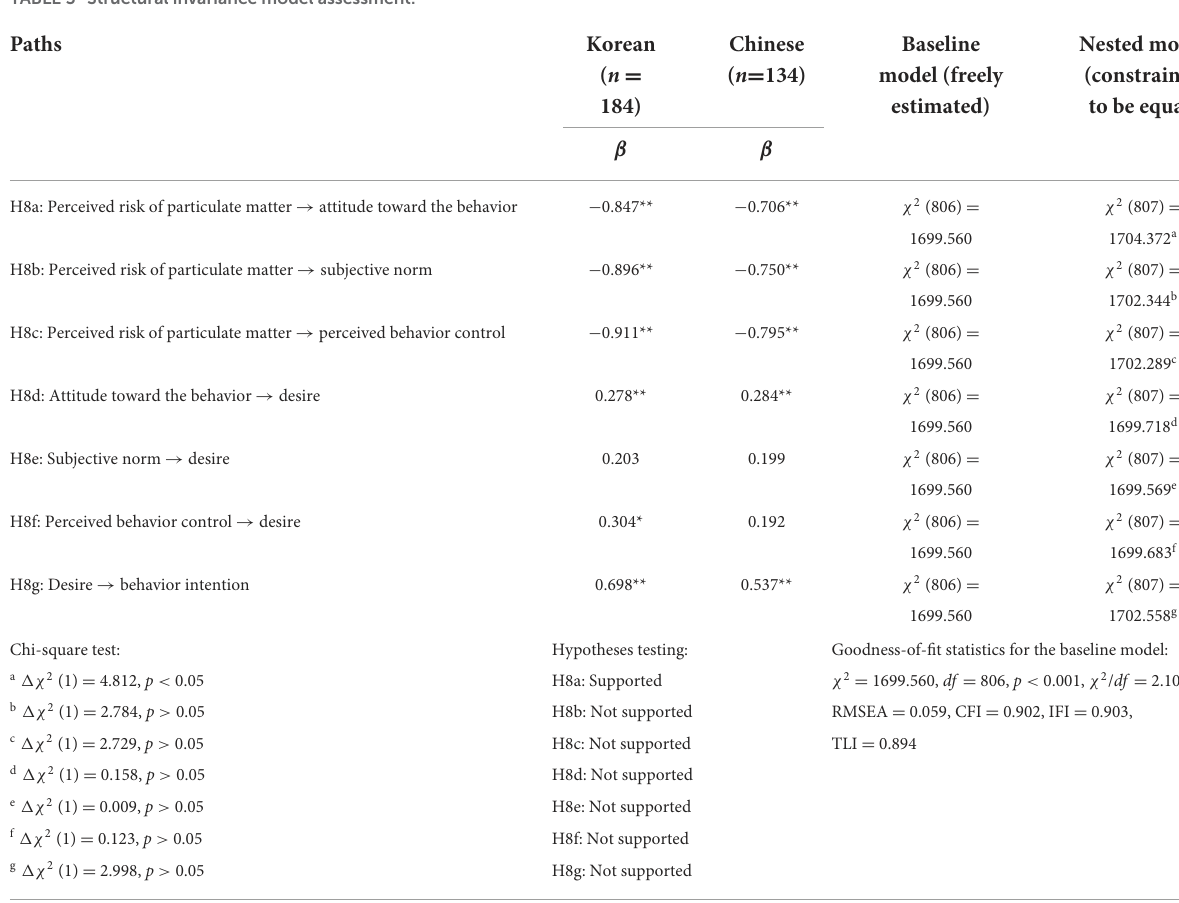
TABLE 3 Structural invariance model assessment. Paths Korean